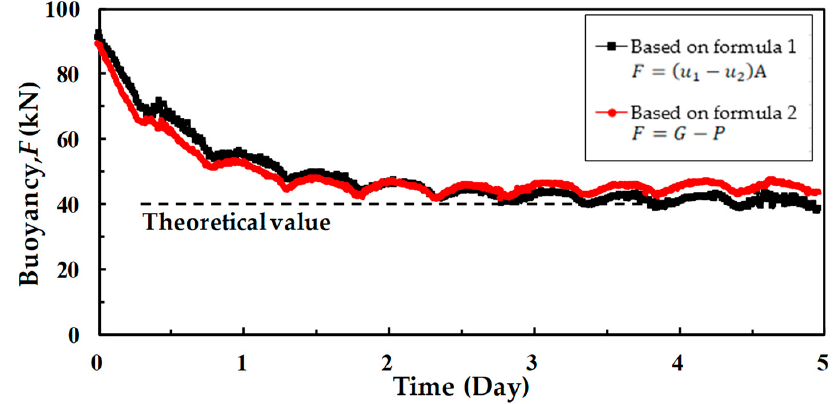
Figure 7. Variation of buoyancy (based on two calculation methods) during the sitting time of 5 days.